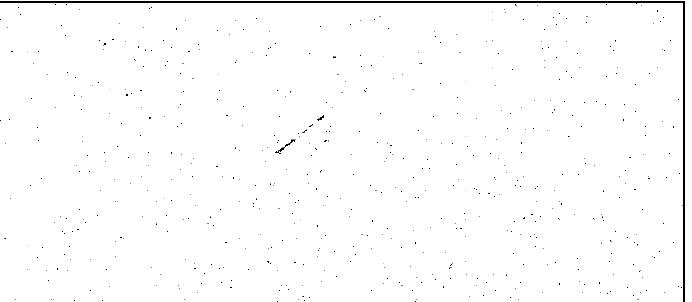
Figure 11. Candidate satellite pixels obtained by foreground-background difference